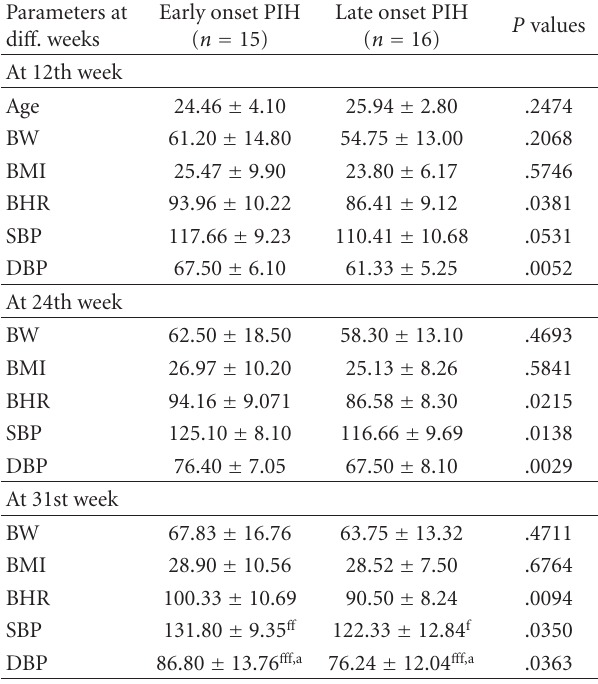
Table 3: Comparison of age, body weight (BW), body mass index (BMI), heart rate (HR), systolic blood pressure (SBP) and diastolic blood pressure (DBP) between early onset PIH (before completion of the 34 weeks) and late onset PIH (after completion of the 34 weeks).